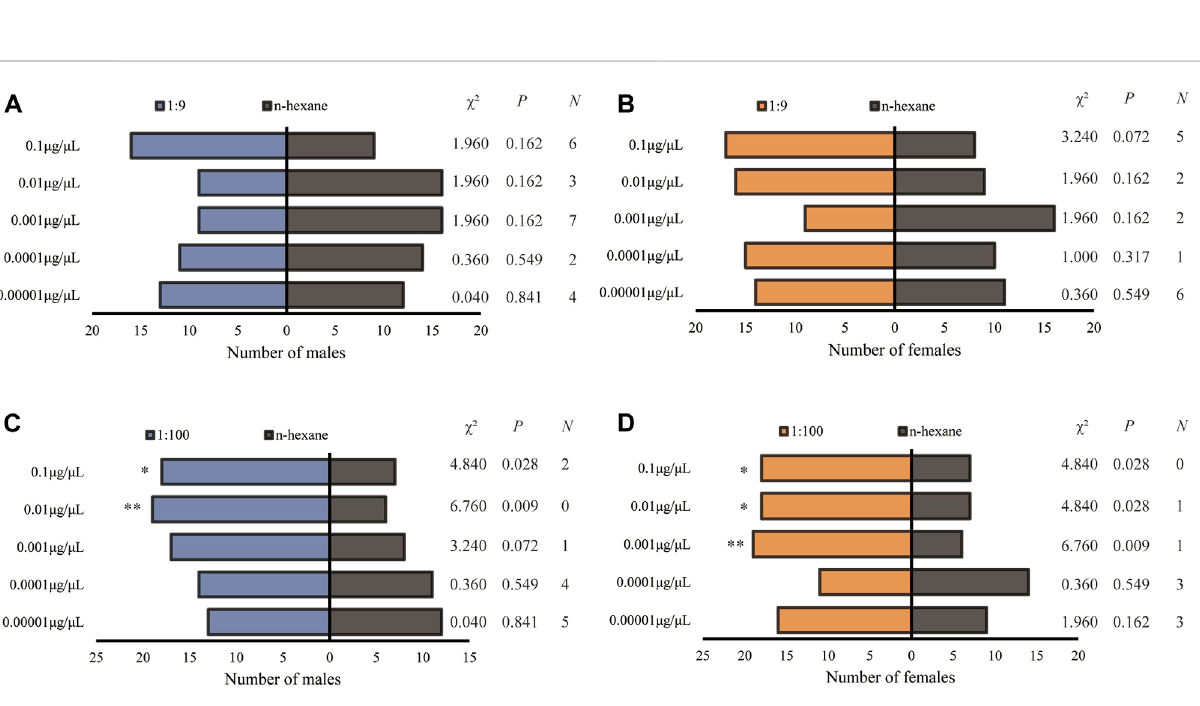
(Supplementary Table S1). In addition to these three OBPs, the other 16 OBPs used trRosetta for 3D structure prediction. The predicted results all matched very high (Supplementary Table S2). In order to provide evidence on whether H. axyridis could sense and detect S. used to analyze the molecular interactions between identi fi ed HaxyOBPs and Z7-12:Ac or Z9-14:Ac respectively. The results revealed that HaxyOBP12 has a good af fi nity with Z9-14:Ac (Total score = 8.261, C-score = 4). However, there were no credible docking results between HaxyOBPs and Z7-12:Ac (Table 1). Z9-14:Ac bound to HaxyOBP12 by hydrogen bonding interactions and hydrophobic interactions (Figure 6). The Z9-14:Ac was stabilized by a hydrogen bond with Ala119 of HaxyOBP12 (3.00 Å). Additionally, Z9-14:Ac was also buried in tight